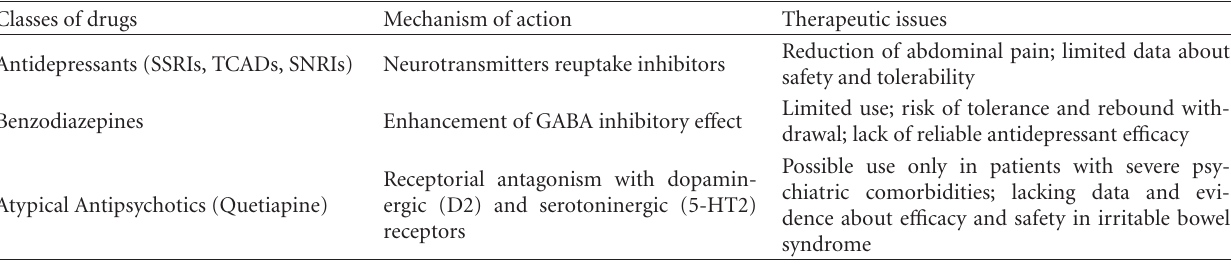
Table 1: Current psychotropic drugs used for treatment of irritable bowel syndrome.